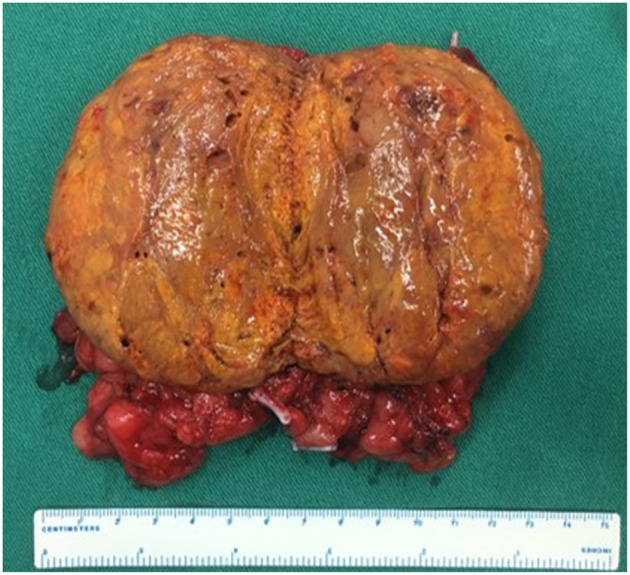
Same as Figure 2.